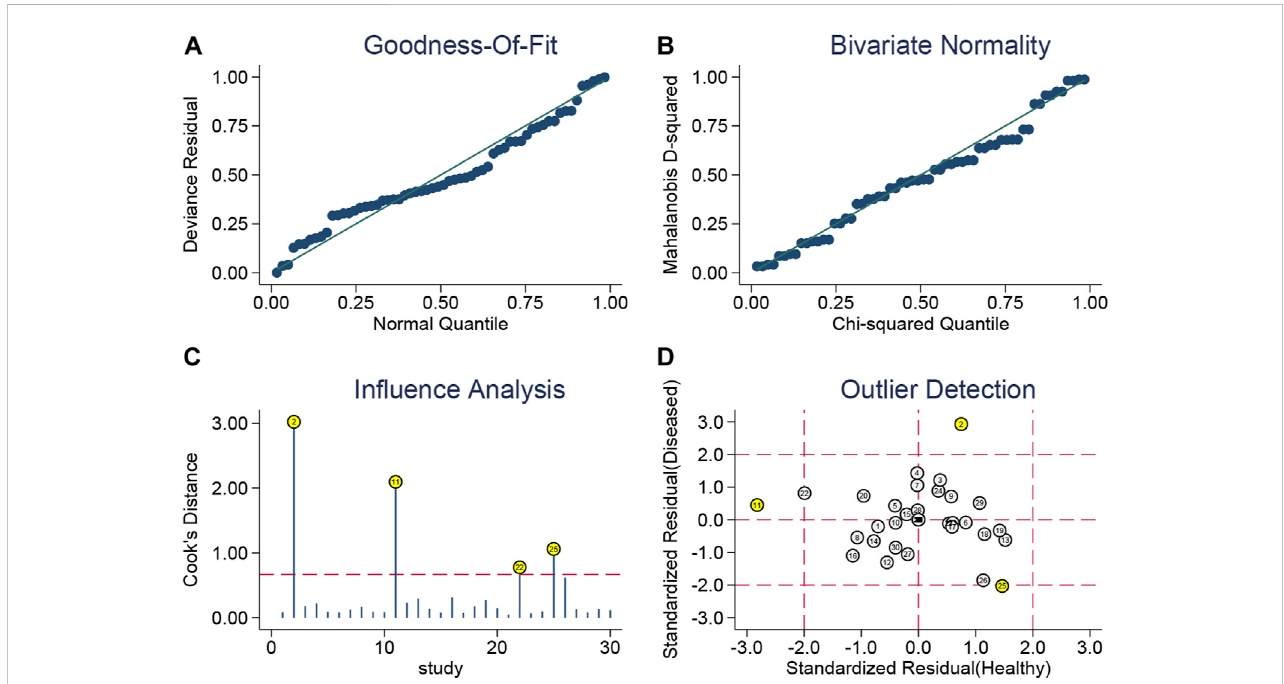
FIGURE 3 Golf diagram of (A) goodness-of- fi t, (B) bivariate normality, (C) in fl uence analysis, and (D) outlier detection. The bivariate random-effects model ’ s suitabilityiscon fi rmedbyplottingthegoodness-of- fi tandbivariatenormality.In fl uenceanalysisrevealedthatdatasetsnumbered2,11,22,and25thatbelong tothelet-7family,MALAT1,miR-34a,andprecursormiR-203ahadCook ’ sdistancesgreaterthan0.75andwerethemostin fl uential.Datasetsnumbered2,11, and 25 (related to the let-7 family, MALAT1, and precursor miR-203a, respectively) were detected as outliers, potentially accounting for some of the heterogeneity that we